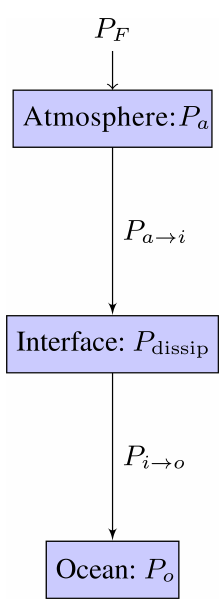
Figure 1. Schematic of energy fluxes in the atmosphere–ocean sys-